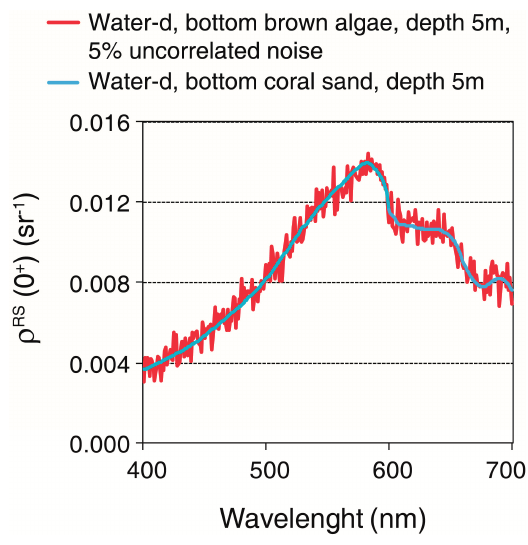
Figure 9. Simulated remote sensing reflectance (sr − 1 ) above water as a function of wavelength (nm) in shallow waters (5 m depth) with chl- a = 9 µg·L − 1 , a suspended particles Type I = 10 mg·L − 1 , suspended particles Type II = 1 mg·L − 1 and a (440) = 0.5. The blue curve corresponds to brown algae substrate, while the red d